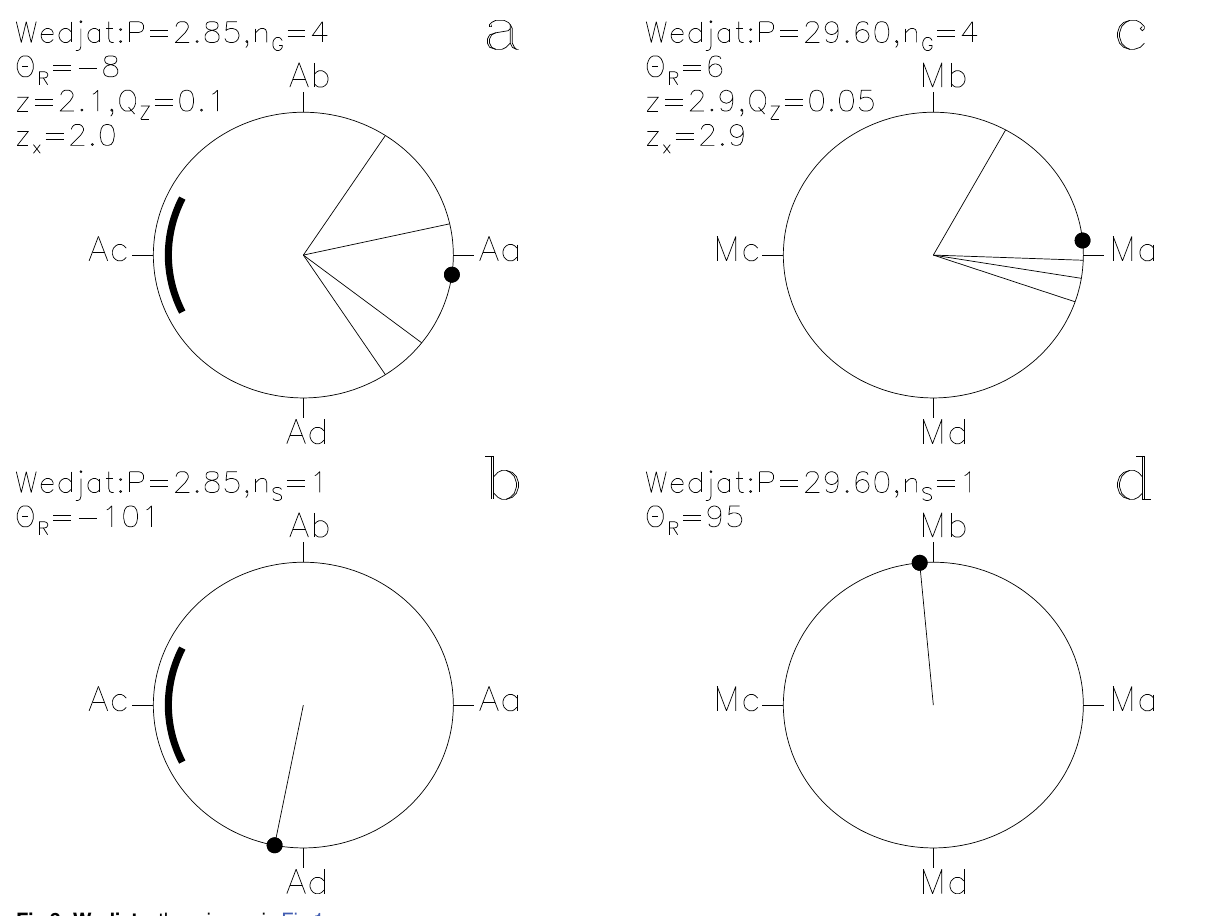
Fig 3. Wedjat. otherwise as in Fig 1 unlucky prognoses with the ephemeris of Eq (11) are shown in Fig 1ab. Point Aa is at ϕ = 0 (cid:7) 0°. Points Ab, Ac and Ad are separated by Δ ϕ = 0.25 (cid:7) 90°. Only the g